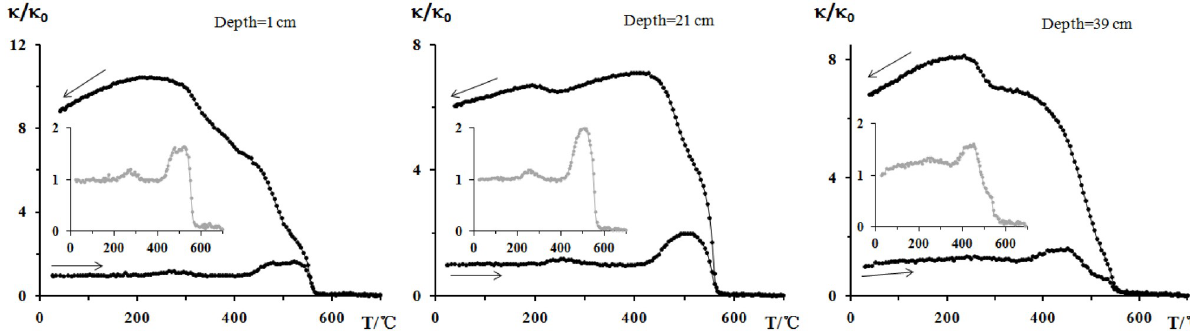
Fig 2. High-temperature κ –T curves of pilot samples (grey lines indicate heating curves).